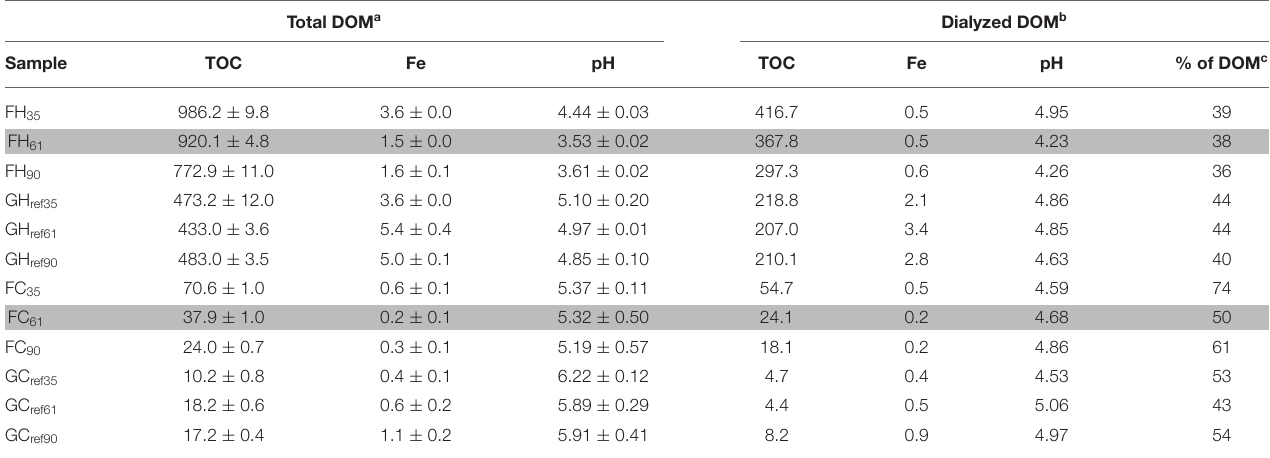
TABLE 1 | Chemical composition of the DOM